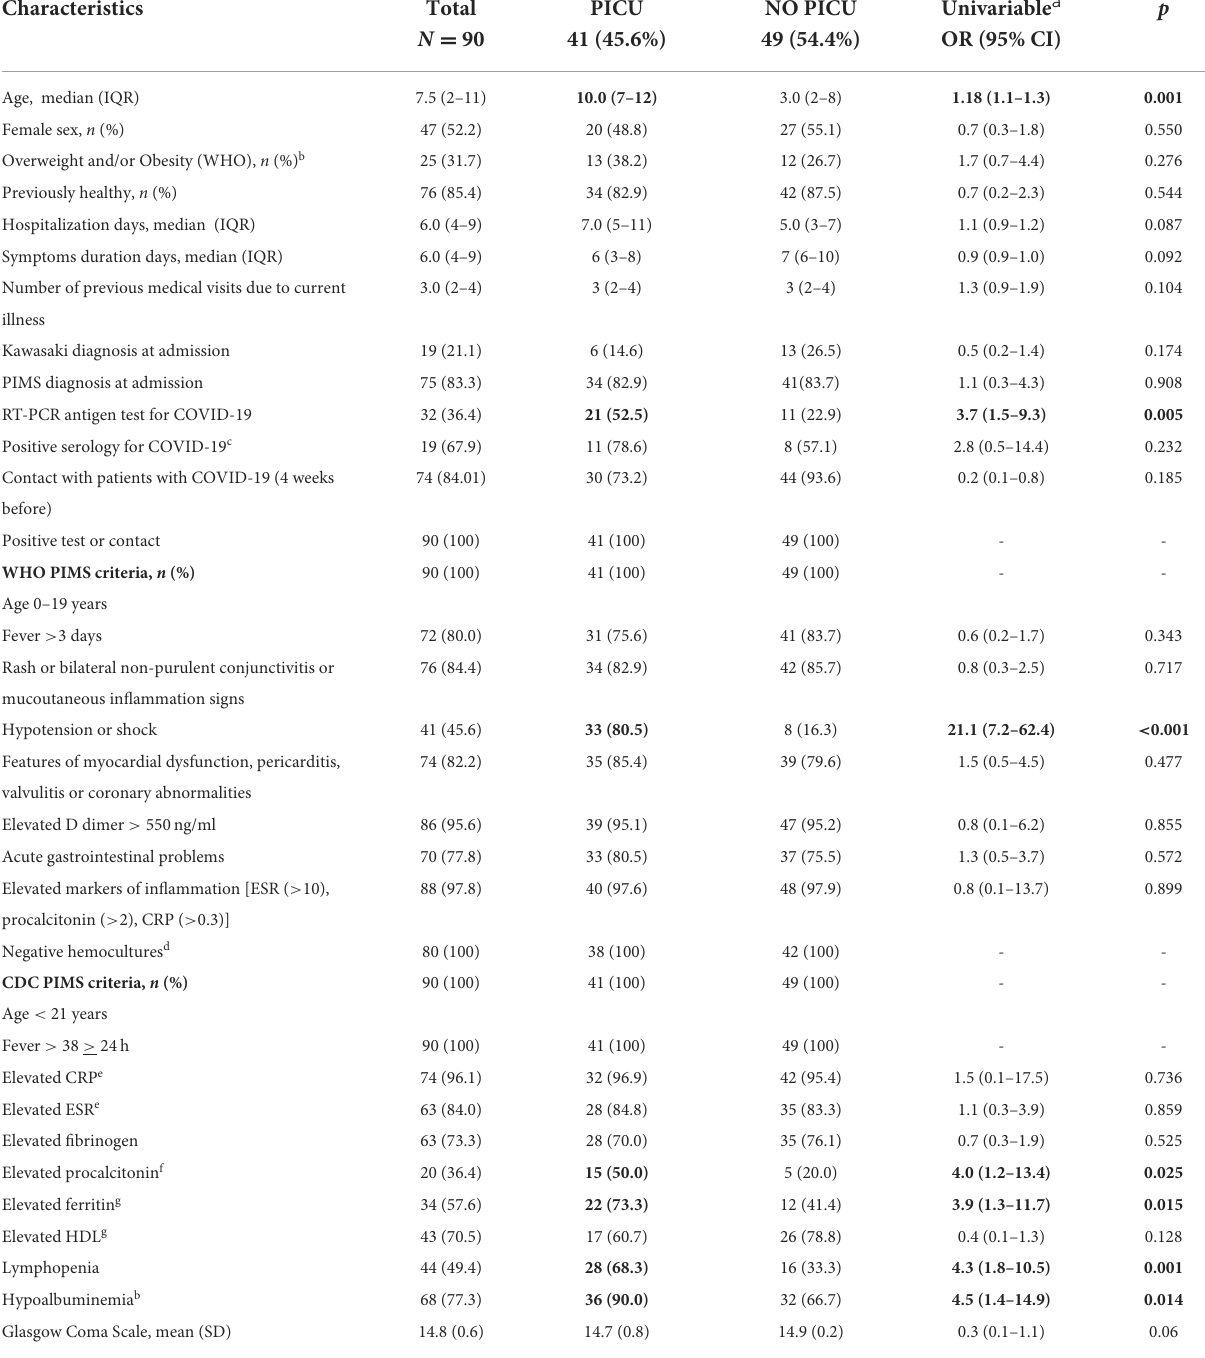
TABLE 1 Demographic, clinical characteristics, and laboratory data at baseline in patients with Multisystem Inflammatory Syndrome in Children in Hospital Infantil de México Federico Gomez by PICU admission status, from March 2020 to January 2022.